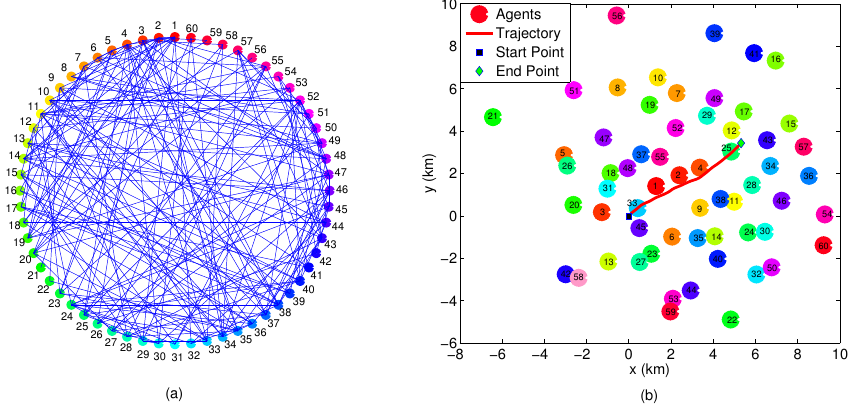
Figure 11. Examples of networks with 60 sensors: ( a ) Graph-topological map of the network; ( b ) Sensors’ true locations and target